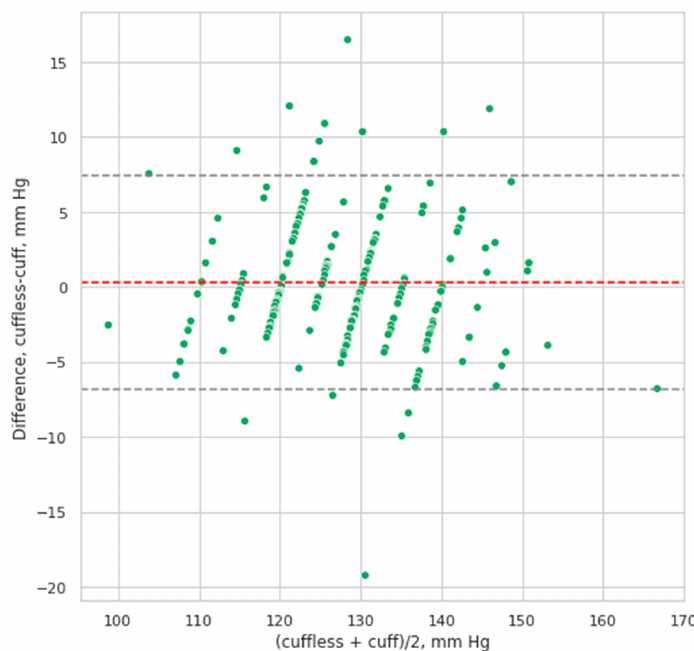
Figure 4. Bland–Altman plot of systolic blood pressure values derived from cuff based versus cuffless measurements. The mean difference between the cuffless–cuff values for DBP was 0.35 ± 2.95 mm Hg, the 95% CI of mean difference was (0.093; 0.61), according to the Student’s t -test results, the mean was not equal to 0 ( p = 0.008). Here the cuffless method also slightly underestimates DBP. The correlation between the 2 measurement techniques for DBP was r = 0.87 (Spearman’s correlation, p = 0.002) (Figure 5).